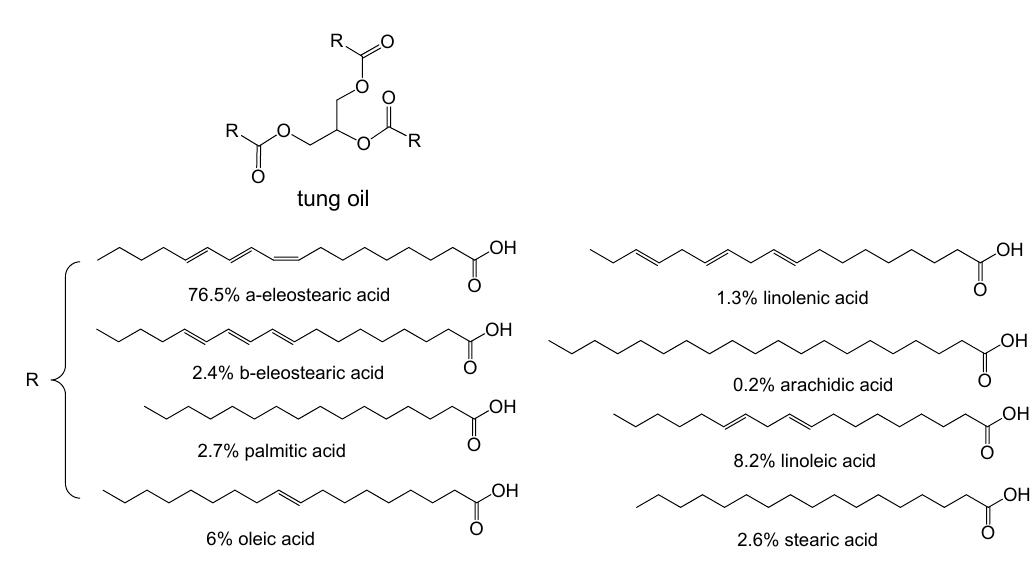
Figure 2. Chemical structure of tung oil.